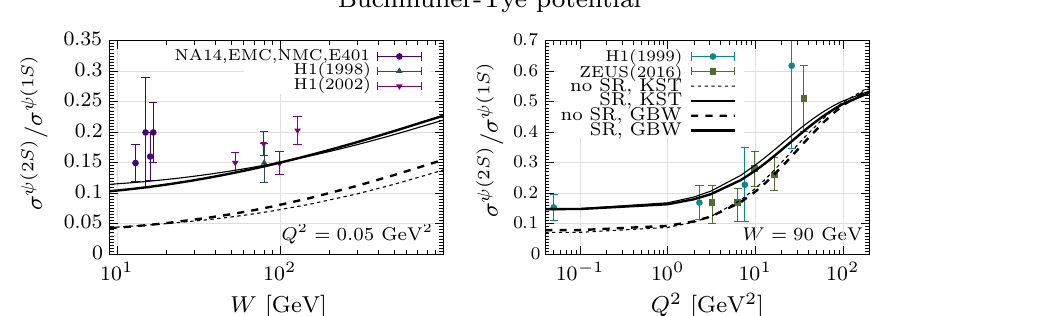
representmodelcalculationswithandwithouteffectsoftheMeloshspin rotation, respectively. The thin and thick curves corresponds to calcula- tions using the phenomenological KST [35] and GBW [39] dipole cross sections,respectively.TheexperimentaldatapointsaretakenfromRefs.